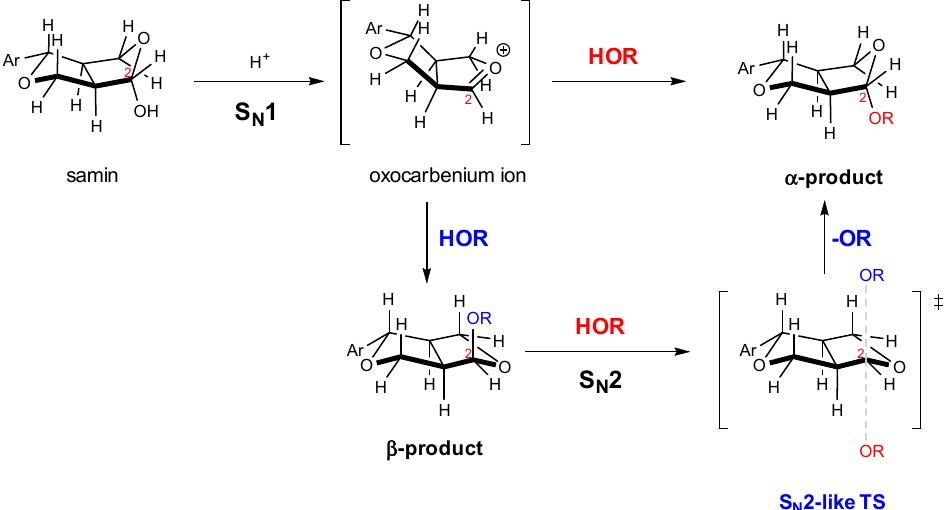
Scheme 3. Proposed mechanism of ether furofuran lignan formation.